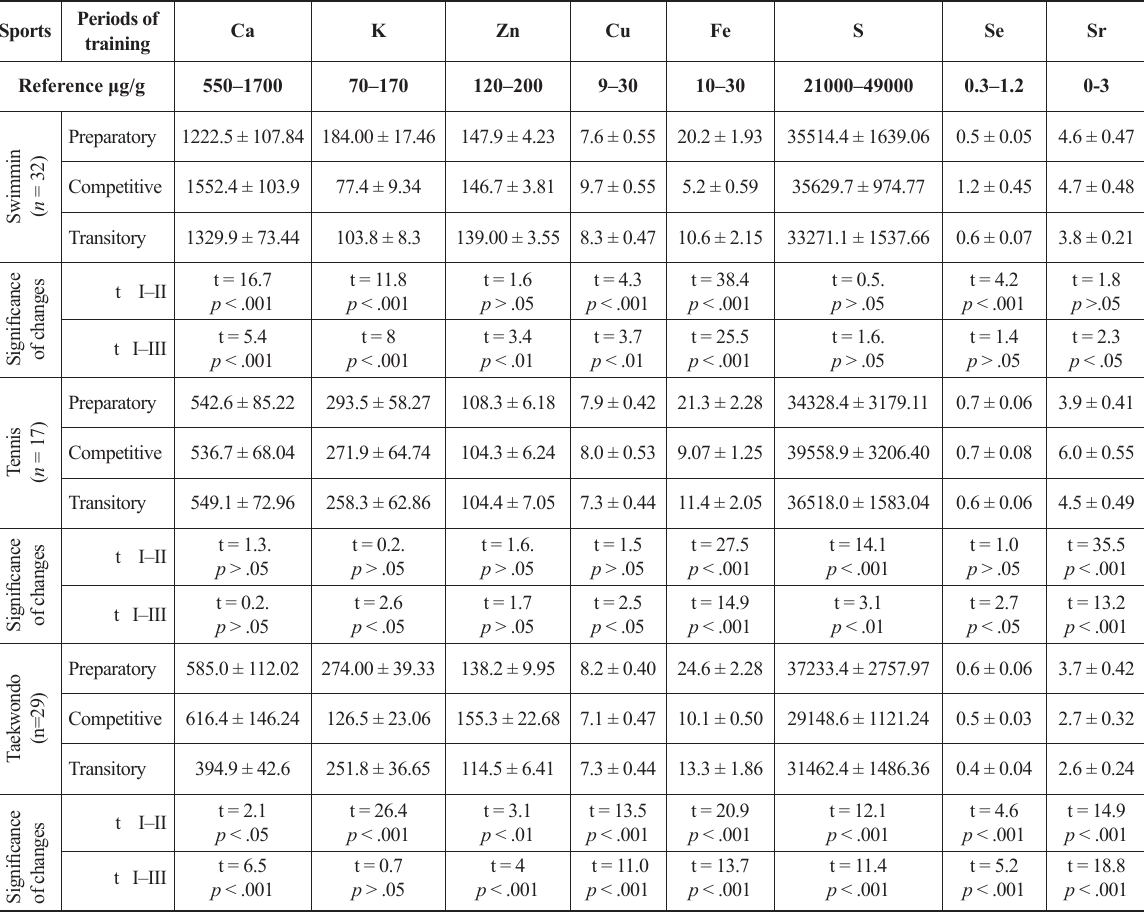
Table. Changes in concentration of macro – and microelements in hair samples of young athletes within one-year training cycle (X ±